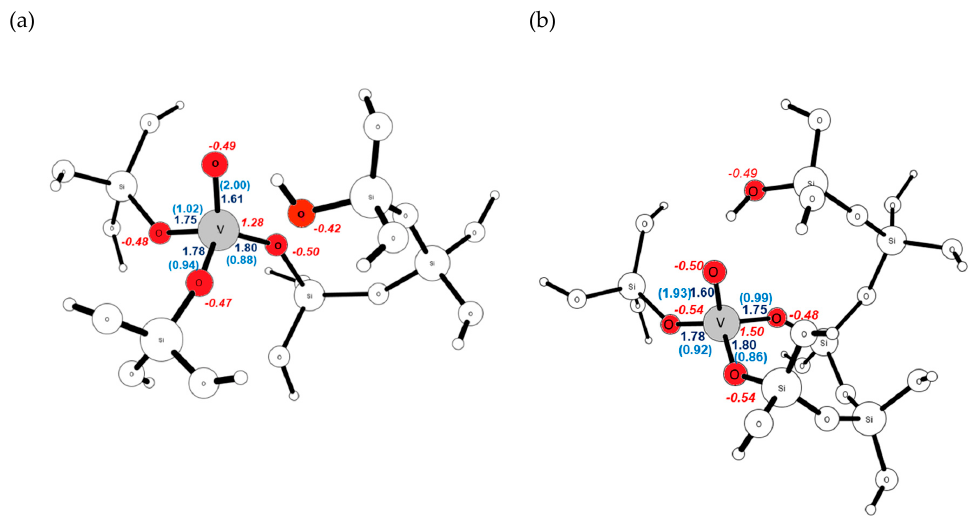
Figure 5. The parameters of the V = O center in the ( a ) T2 and ( b ) T3 positions (navy—bond lengths in Å; blue, in parentheses—bond order indices; red—Mulliken charges).